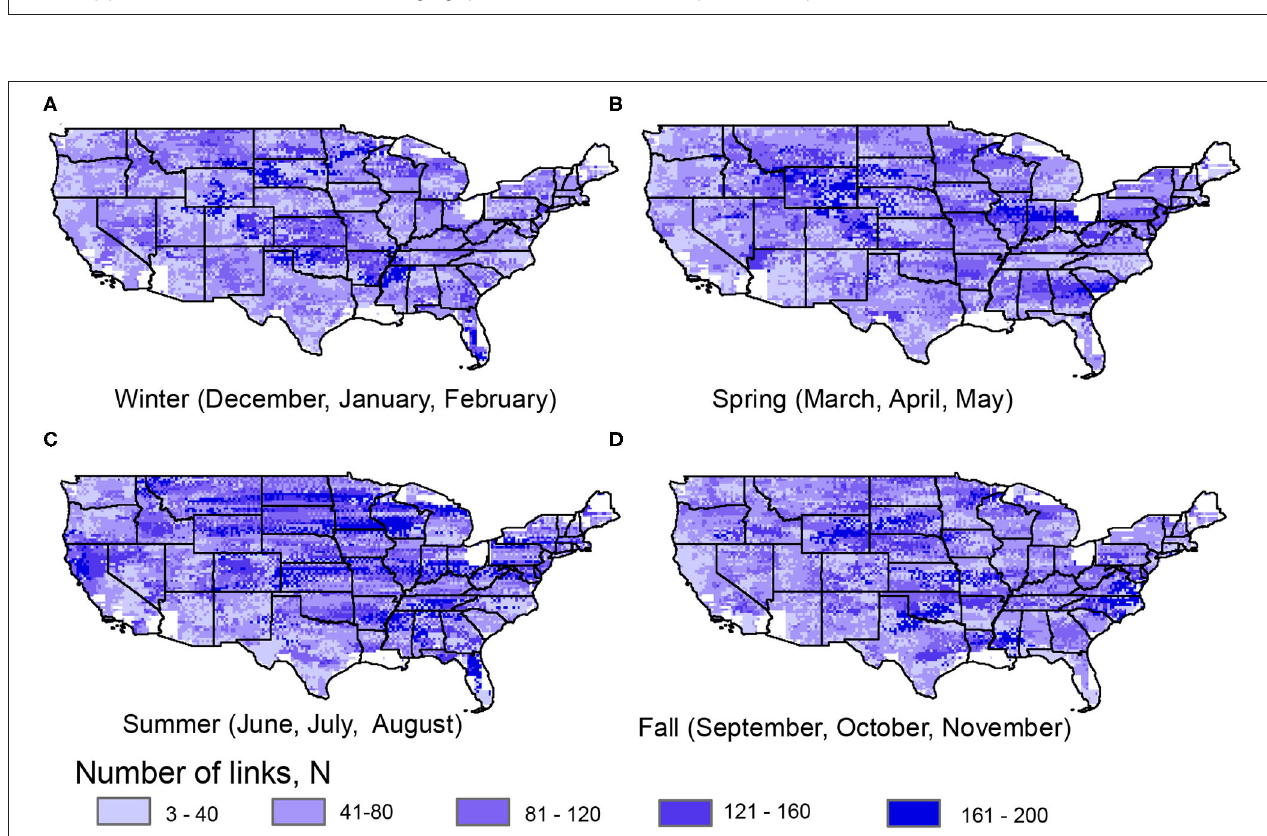
FIGURE 5 | Number of links ( N ) for precipitation chains for (A) winter, (B) spring, (C) summer, and (D) fall. White areas indicate regions where no precipitation chain was constructed, either due to neighboring coastal or water grid cells, a lack of statistically significant relationships with neighbors.